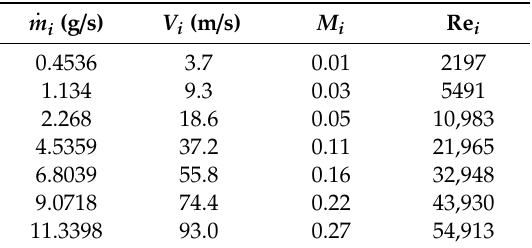
Table 1. Inlet boundary